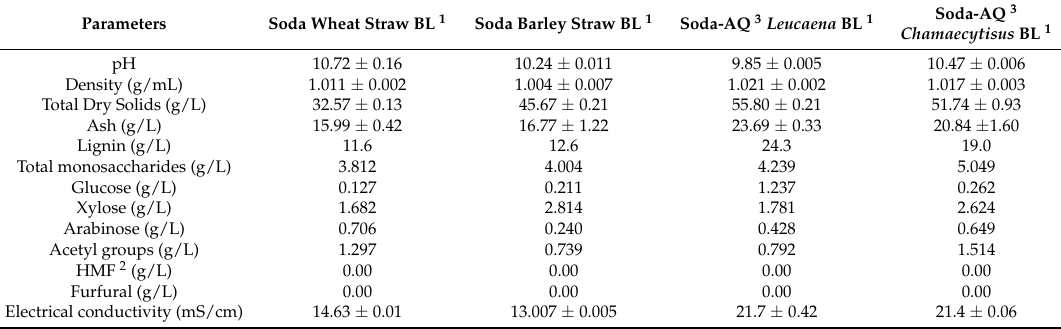
Table 1. Physicochemical properties of the black liquors derived from the different raw materials.